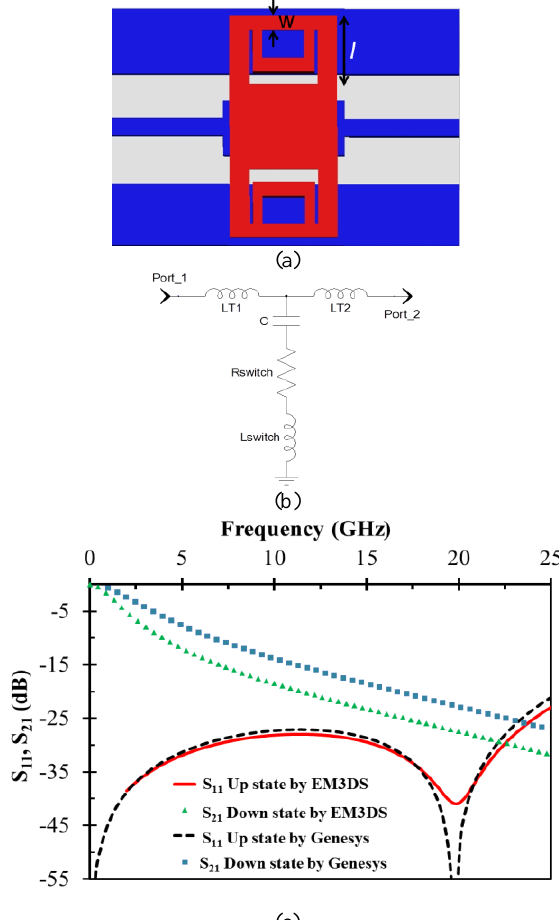
(SHITL) for Z h =100 Ω can be calculated by Eq. (12).